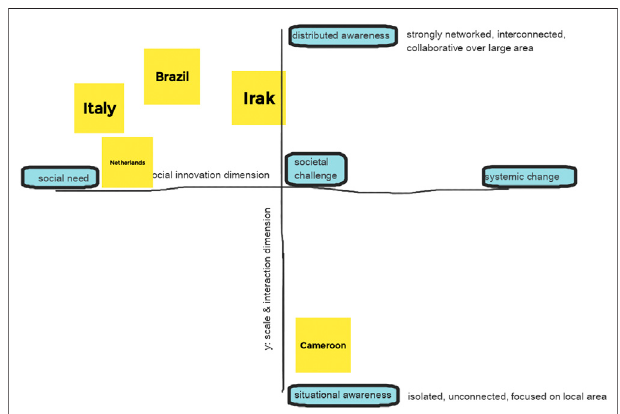
FIGURE 4 | Case positioning on scale and social innovation